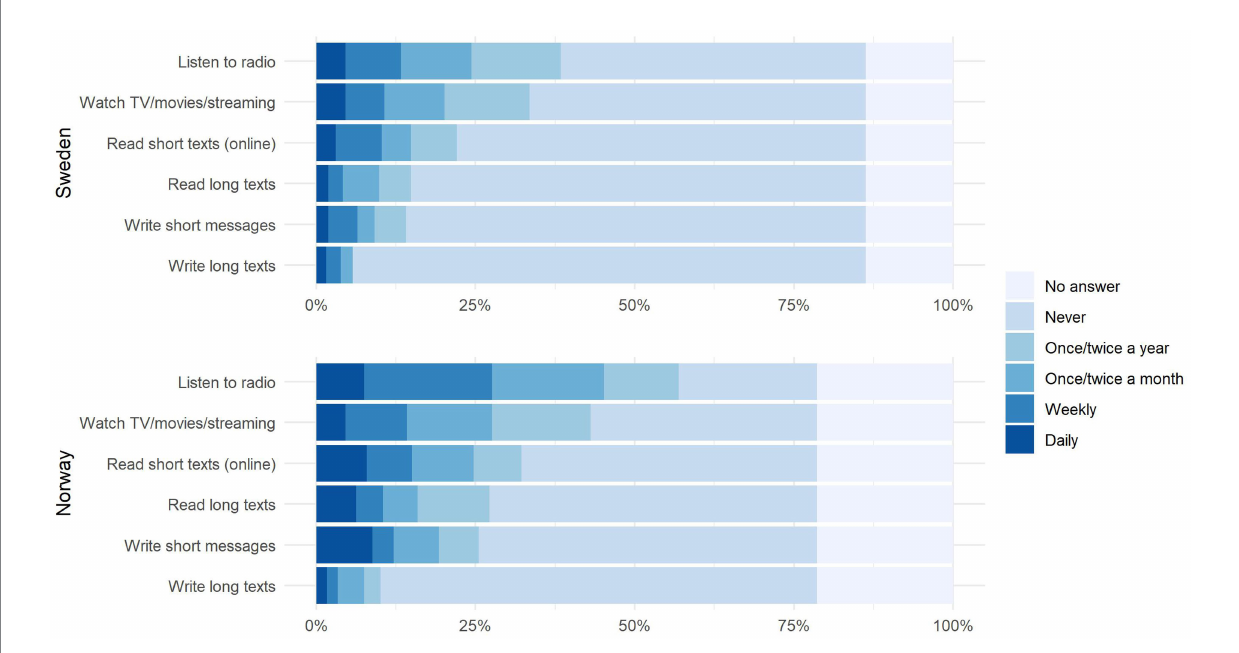
FIGURE 7 Frequency of Sámi language engagement outside the family (e.g., media and internet) for Norway (top) and Sweden (bottom).